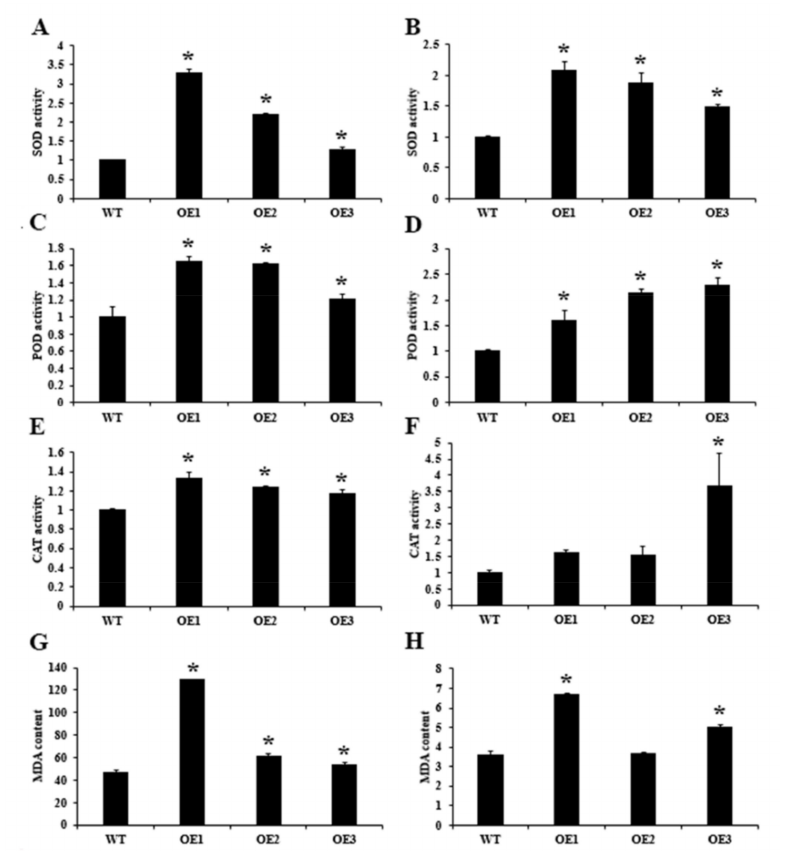
Figure 4. Relative ROS-related enzyme activities and MDA contents in Arabidopsis seedlings after 3 days of hyperosmotic treatment (10 % PEG 6000). ( A ) Relative SOD activity in leaves. ( B ) Relative SOD activity in roots. ( C ) Relative POD activity in leaves. ( D ) Relative POD activity in roots. ( E ) CAT content in leaves. ( F ) CAT content in roots. ( G ) MDA content in leaves. ( H ) MDA content in roots. WT, wild type; OE1, overexpression line 1; OE2, overexpression line 2; OE3, overexpression line 3. * represents significant difference at p < 0.05 versus the wild type. The results were obtained from three biological experiments with three technical